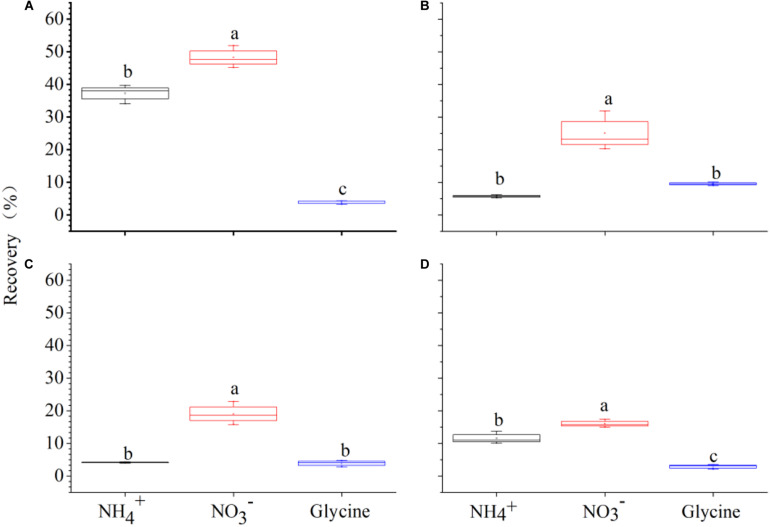
15N recovered by Polygonum criopolitanum (% of added 15N) from NH4+, NO3-, and glycine-N 2 h after 15N injection under competition regime of 4:0 (Polygonum criopolitanum: Carex thunbergii, A), 3:1 (B), 2:2 (C), and 1:3 (D), respectively. The bars and error bars show means ± SE (n = 3).